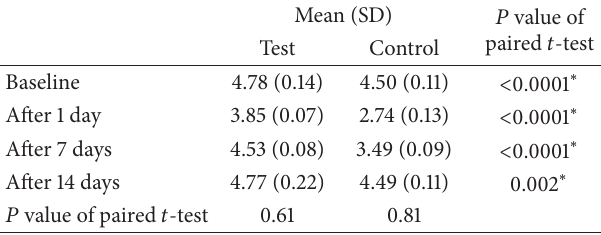
Table 2: Comparison of trismus (mouth opening) between test and control at different follow-up periods (in millimeters).